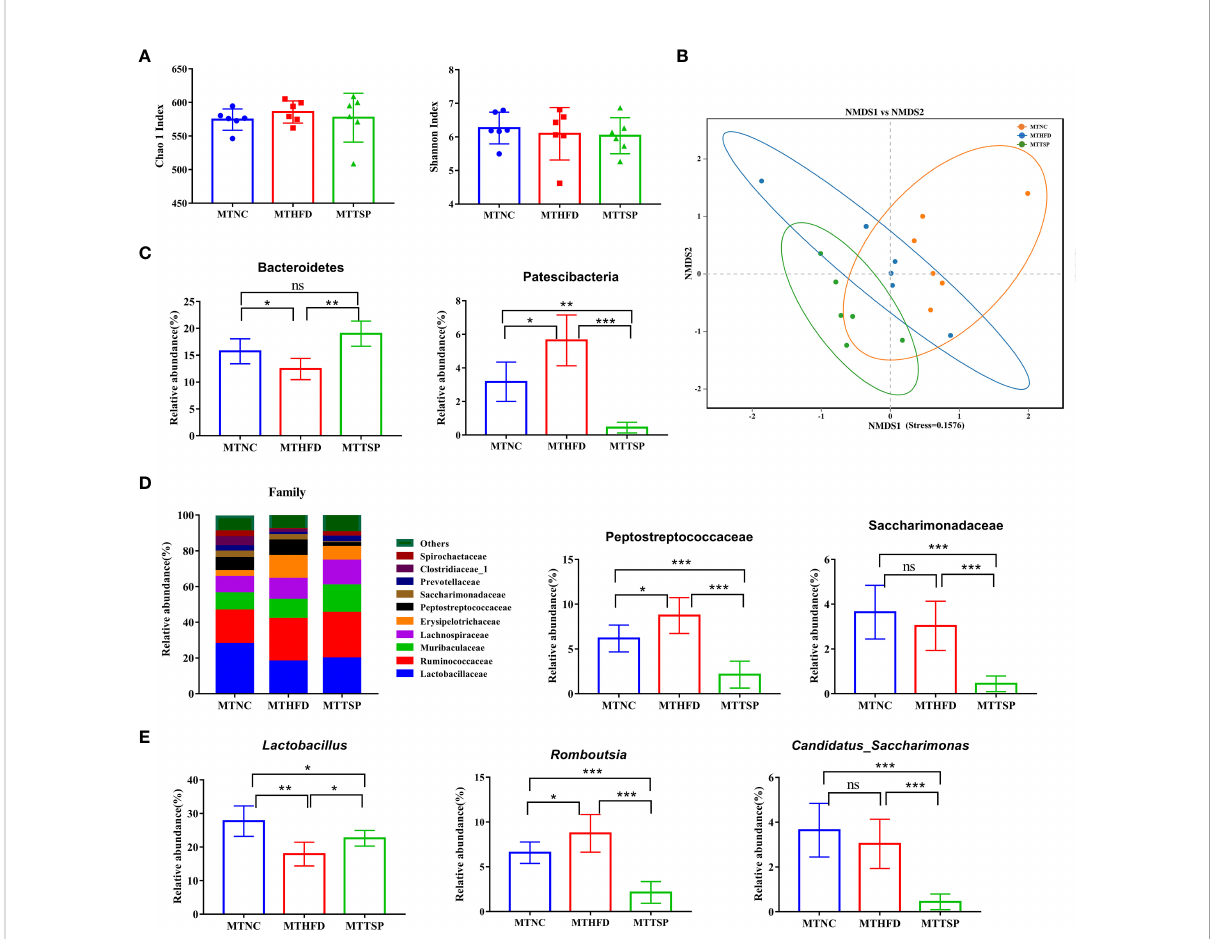
FIGURE 10 Gut microbiota in response to microbiota transplantation from NC (MTNC), HFD (MTHFD), and TSP (MTTSP) groups (n = 6), (A) Indexes of Chao 1 and Shannon in a -diversity analysis, (B) NMDS plot analysis from each sample, (C) signi fi cantly changes of the composition of the gut microbiota at phylum taxa level ( p < 0.05), (D) microbiota compositions at the family level, and (E) signi fi cantly changes of the composition of the gut microbiota at the genus level ( p < 0.05). Data are expressed as mean ± SD, * p ** p *** p /span>, ns, no signi fi cant, p >